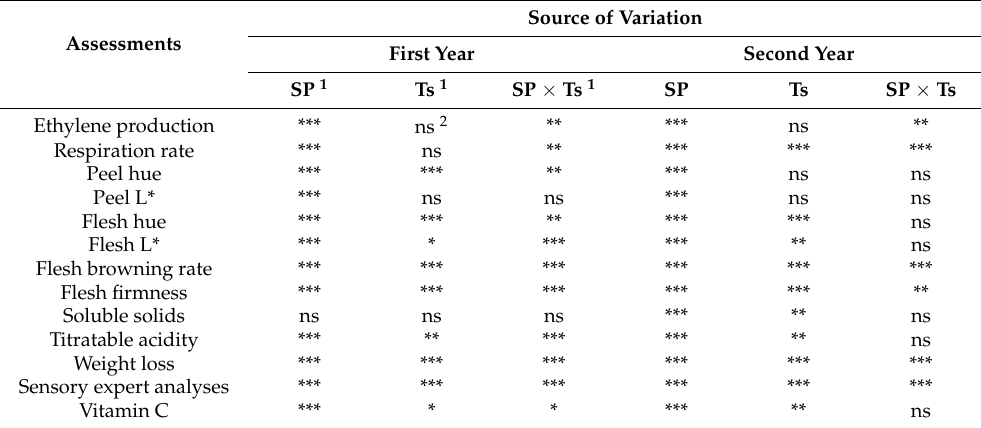
Table 1. Significance of influence ( p ) of storage period and different postharvest treatments on some traits of quince fruit. 0.01, and 0.001 significance levels, respectively.